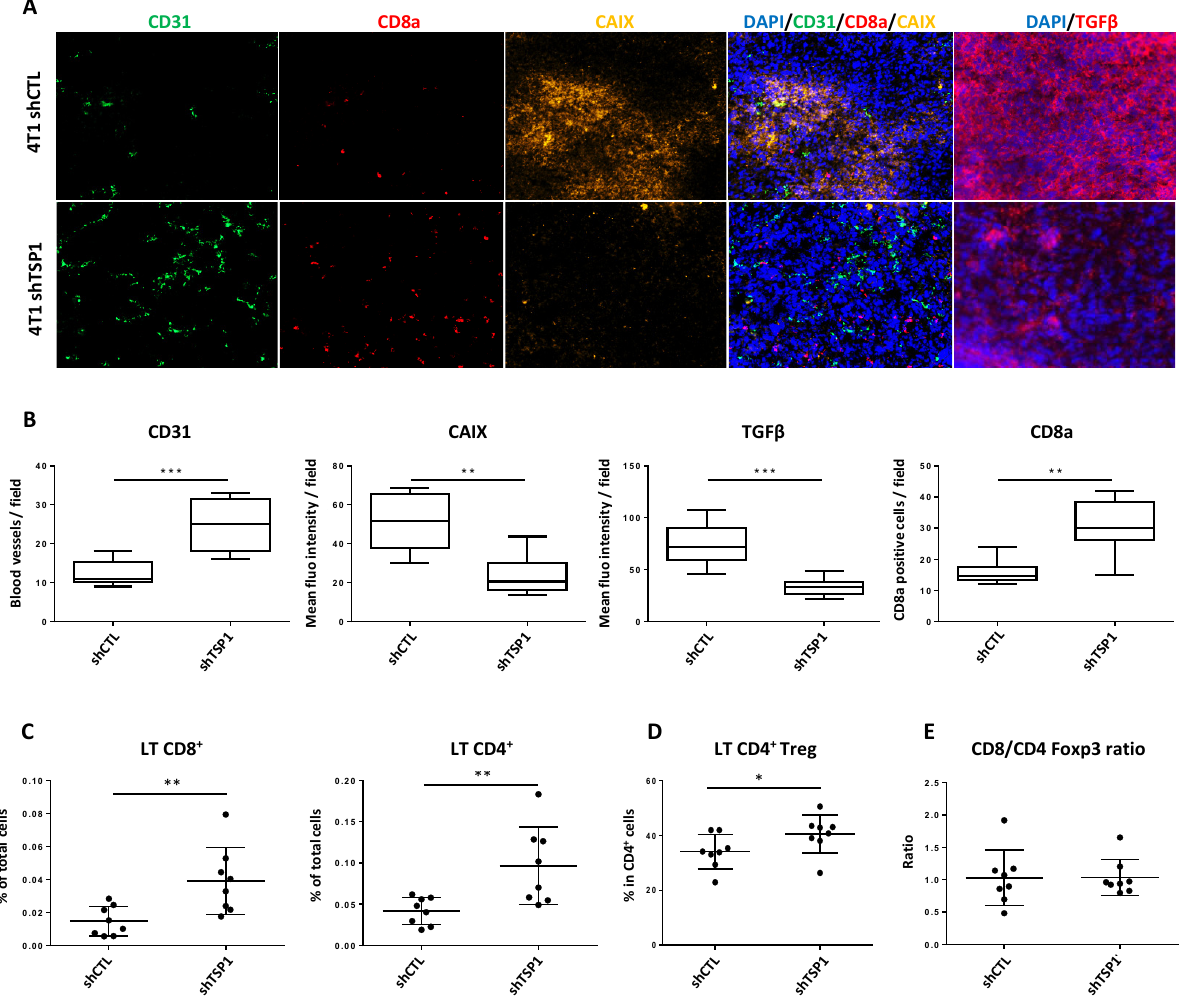
Figure 4. Impact of TSP1 expression on tumor microenvironment in 4T1 mouse breast cancer model. ( A ) Immunodetection of CD31, CD8 α , CA-IX and active TGF- β in 4T1 shCTL and 4T1 shTSP1 tumors 11 days after cell injection in Balb/c mice. ( B ) Quantification in 4T1 shCTL and 4T1 shTSP1 tumors of blood vessels, CD8+ TILs, CA-IX and active TGF- β -positive area. Data obtained in 8 mice are represented as Tukey boxes. ( C – E ) Alternatively, tumors were collected at day 11 and dissociated, and the tumor cell content was analyzed by using flow cytometry ( n = 8 mice per group). Bars are means ± SEM (*: p < 0.05; **: p < 0.01; ***: p < 0.001).